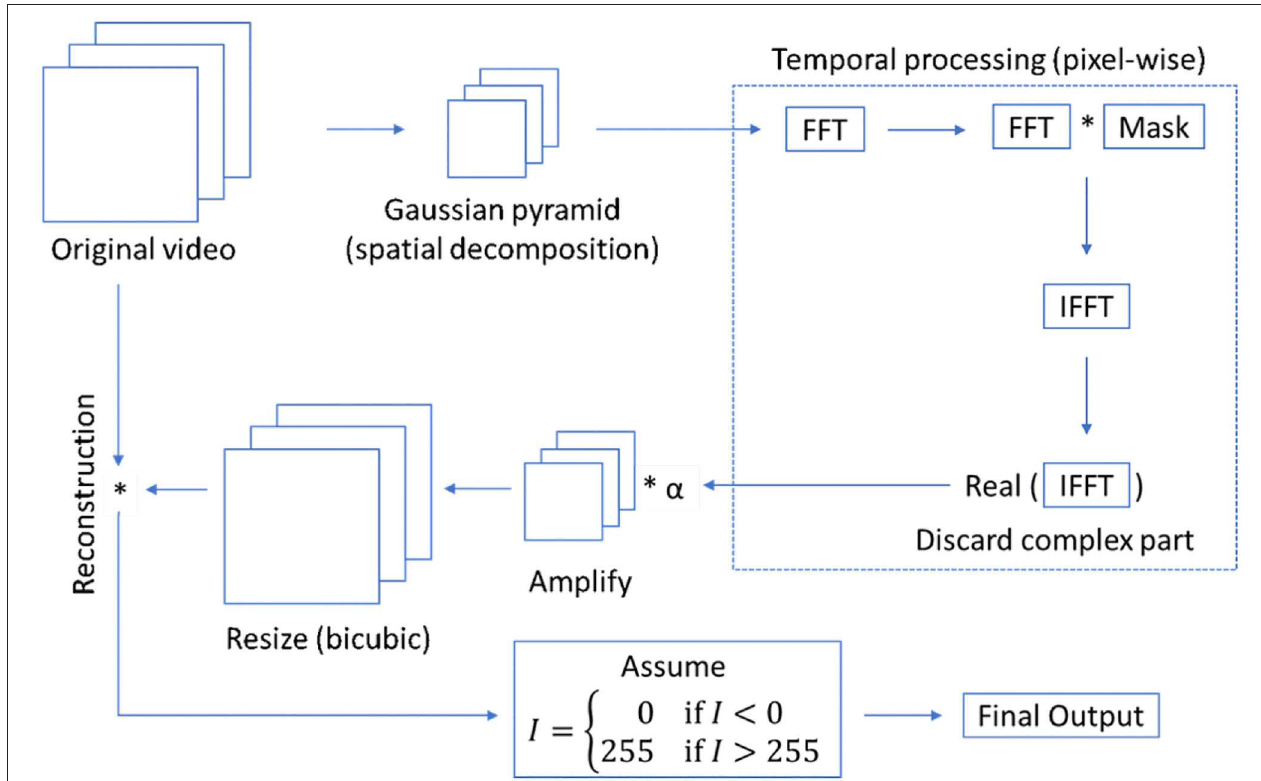
FIGURE 9 | Data flow diagram of Eulerian video magnification for FA video.